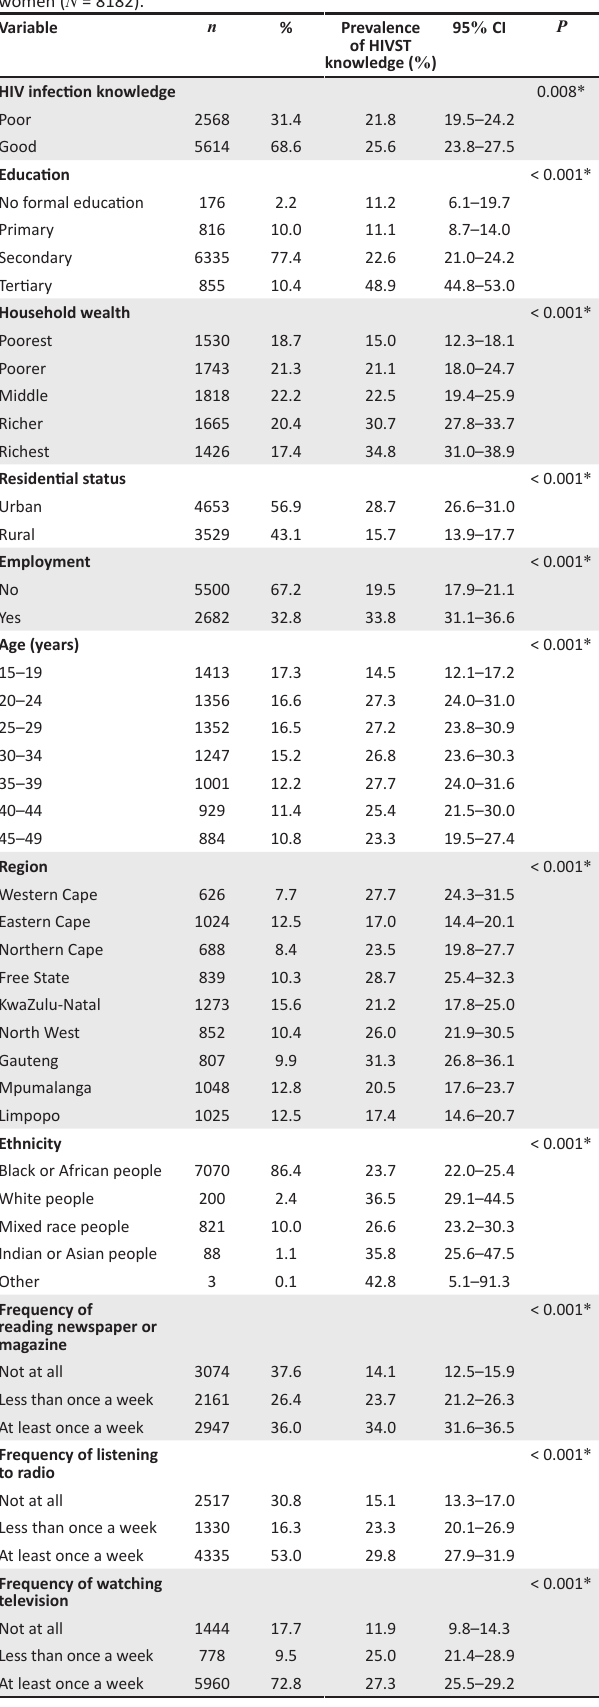
TABLE 2 (Continues...): Distribution of HIV self-testing knowledge amongst South African women ( N =